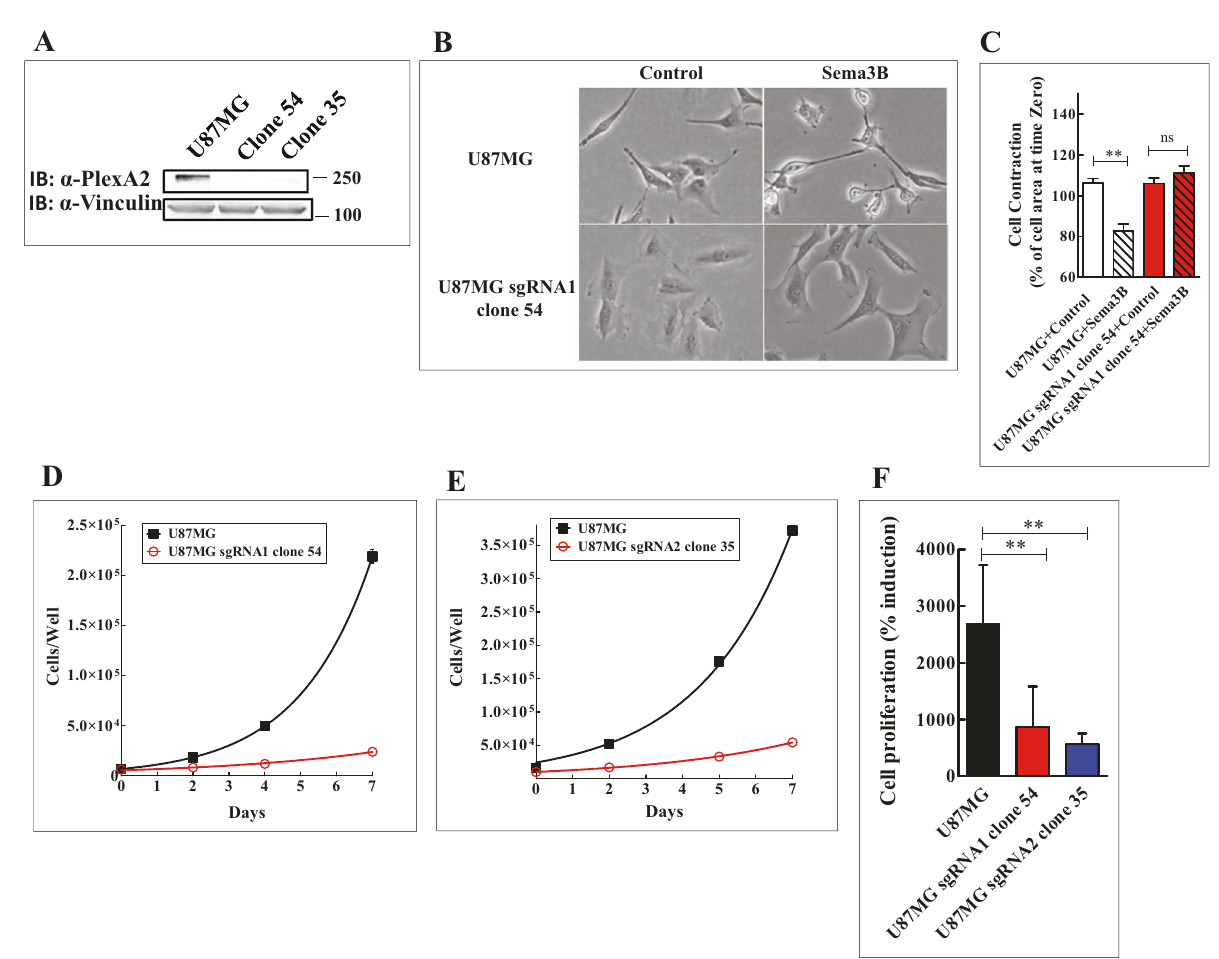
Fig. 2 CRISPR/Cas9 mediated knock-out of plexin-A2 expression in U87MG cells inhibits their proliferation. A Two different guide RNAs were used to knock-out plexin-A2 expression in U87MG cells. Cell lysates of U87MG cells and knock-out cells (U87MG sgRNA1 clone 54 and U87MG sgRNA2 clone 35) were probed with antibodies directed against plexin-A2 or vinculin. B Conditioned medium from HEK293 cells infected with an empty lentiviral expression vector (Control) or from HEK293 cells expressing recombinant sema3B (300 μ l) were added to parental U87MG cells or to U87MG sgRNA1 clone 54. Following a 30 min. incubation at 37 o C the cells were photographed. C U87MG cells and clone 54 plexin-A2 knock-out cells were photographed at the beginning of the experiment and again 30 min after stimulation with sema3B as described under ( B ) using the Incucyte Zoom HD/2CLR System. Changes in the area of the indicated cell types were determined in fi elds derived from three replicate wells using the Image-Pro Premier software. Data are represented as mean ± SD. Statistical analysis was done using the one-tailed Mann-Whitney test. * P < 0.05, ns: non-speci fi c, N = 4. D, E Representative growth curves of U87MG cells and plexin-A2 knock-out clone 54 cells ( D ) and clone 35 cells ( E ). Cells were seeded in quadruplicate (1 × 10 4 cells/well). Adherent cells were counted every two days using a coulter-counter. Data are represented as mean ± SD. F The number of cells attached on day 0 was taken to be 100%. The average percentage of adherent cells on day 7 is shown. Compared were parental U87MG cells ( N = 13), plexin-A2 clone 54 knock-out cells ( N = 8) and plexin-A2 clone 35 knock-out cells ( N = 5). Data are represented as mean ± SD. Statistical analysis was done using the one-tailed Mann-Whitney test. ** P < change was observed in T98G cells in which plexin-A2 expression was silenced (Fig. 6B). Inhibition of plexin-A2 expression is accompanied by decreased AKT phosphorylation and by enhanced phosphorylation of p38-MAPK To identify secondary messengers that transduce the pro- proliferative signals of plexin-A2, we screened for known secondary messengers whose phosphorylation state changes following plexin- A2 knock-out in U87MG cells. These experiments revealed that the phosphorylation of AKT on ser473 is inhibited in plexin-A2 clone 54.3 knock-out cells (Fig. 6C) as well as in clone 35 knock-out cells (Fig. S5C). In contrast the phosphorylation of p38-MAPK was induced on Tyr182 in these cells (Fig. 6D & S5D). The changes we observed in the phosphorylation states of p38 and AKT are speci fi c to plexin-A2 since AKT phosphorylation is restored following expression of